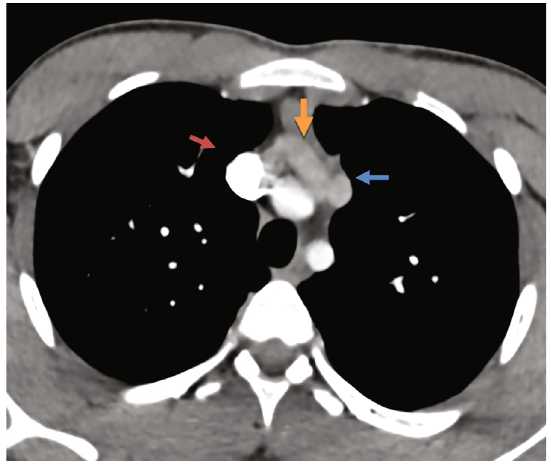
Figure 2: Sagittal slice of the chest. Red arrow=right superior vena cava; blue arrow =persistent left superior vena cava; orange arrow= left innominate